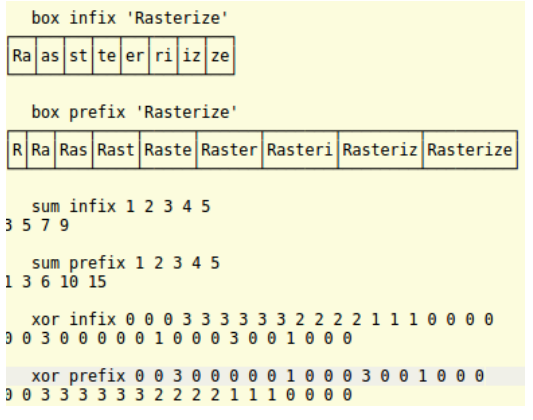
Fig 3. Dialogue in the J programming language illustrating infix and prefix on 'box', 'sum' and 'xor'